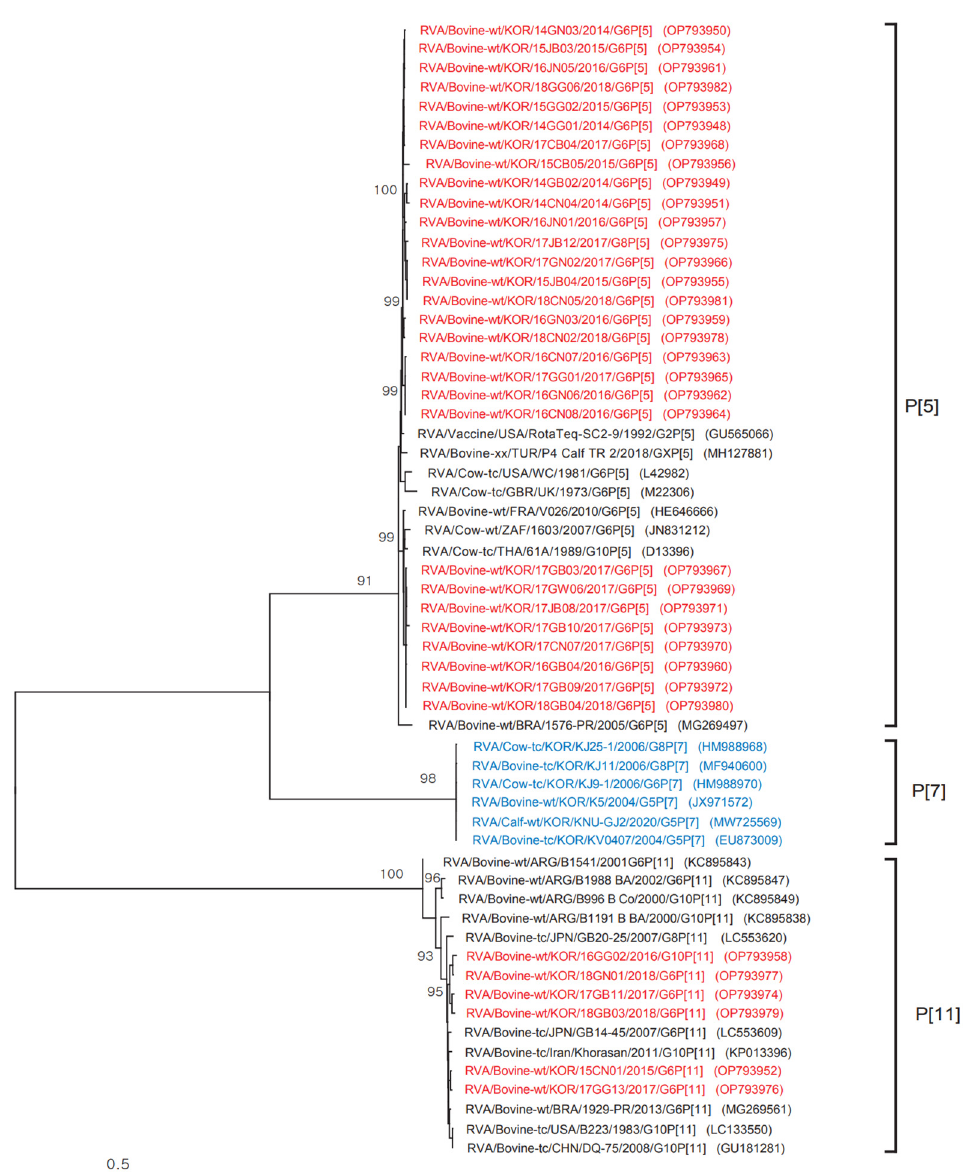
Figure 3. Phylogenetic analysis of a partial nucleotide sequence of the VP4 gene from 35 BoRVA antigen-positive samples and selected reference strains. The phylogenetic tree was constructed using the HKY (Hasegawa–Kishino–Yano) model in the MEGA X program, with 1000 bootstrap values. The 35 Korean BoRVA isolates identified in this study are highlighted in red and Korean BoRVA strains reported by previous studies are highlighted in blue.